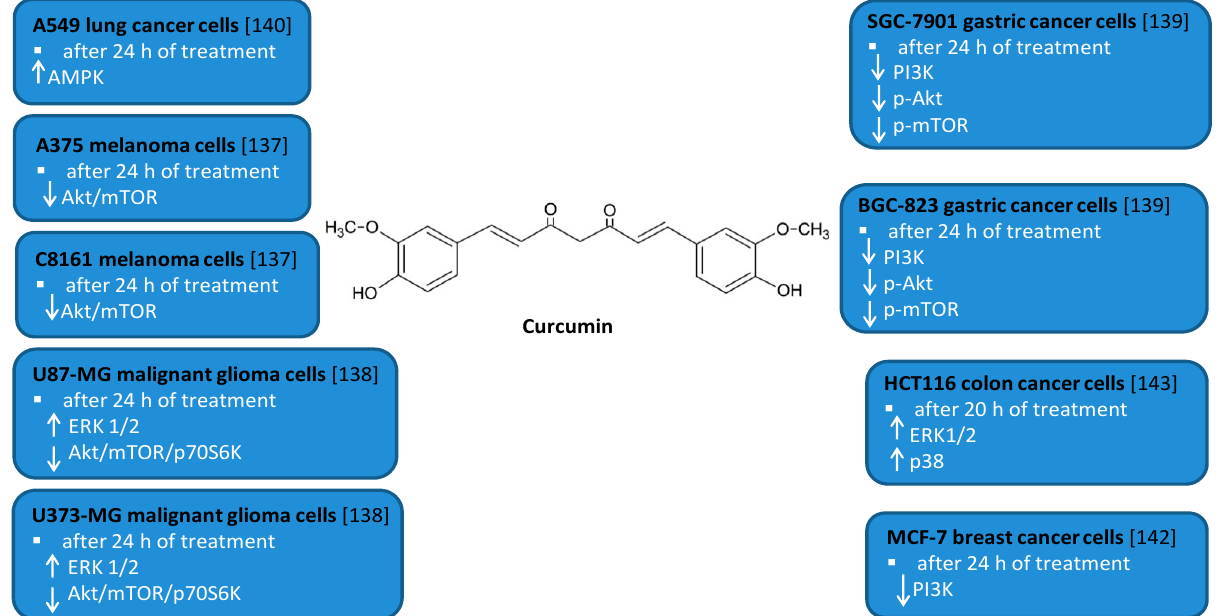
Figure 7. Cell signaling pathways triggered by curcumin in selected cancer cell lines. ↑ activation; ↓ inhibition. Accumulating evidence indicates that administration of CR at high doses may be as- sociated with side effects [144]. Human studies have demonstrated that CR administered at doses ranging from 0.45 to 3.6 g daily for up to 4 months led to some adverse effects such as nausea and diarrhea and caused an increase in serum alkaline phosphatase and serum lactate dehydrogenase [145]. CR has also been shown to be toxic to normal human